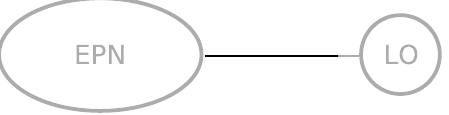
Figure 2.54: The Process Description glyph for logic arc .